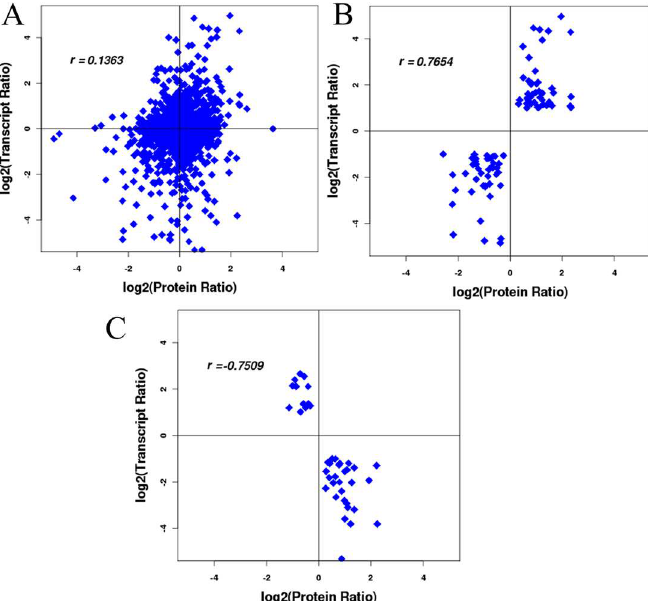
Fig 5. Comparison of expression ratios from transcriptomic and proteomic profiling. (A) The correlationbetweenmRNA and protein when regardlessof the directionof the change.(B) The mRNA and protein levels have the same changetrends. (C) The mRNA and protein levels have the oppositechange trends. Pearson correlationsof the comparisons shownin coordinates as r. The protein ratio was from this study. The transcript ratio was reproducedfrom a previousstudy [22].